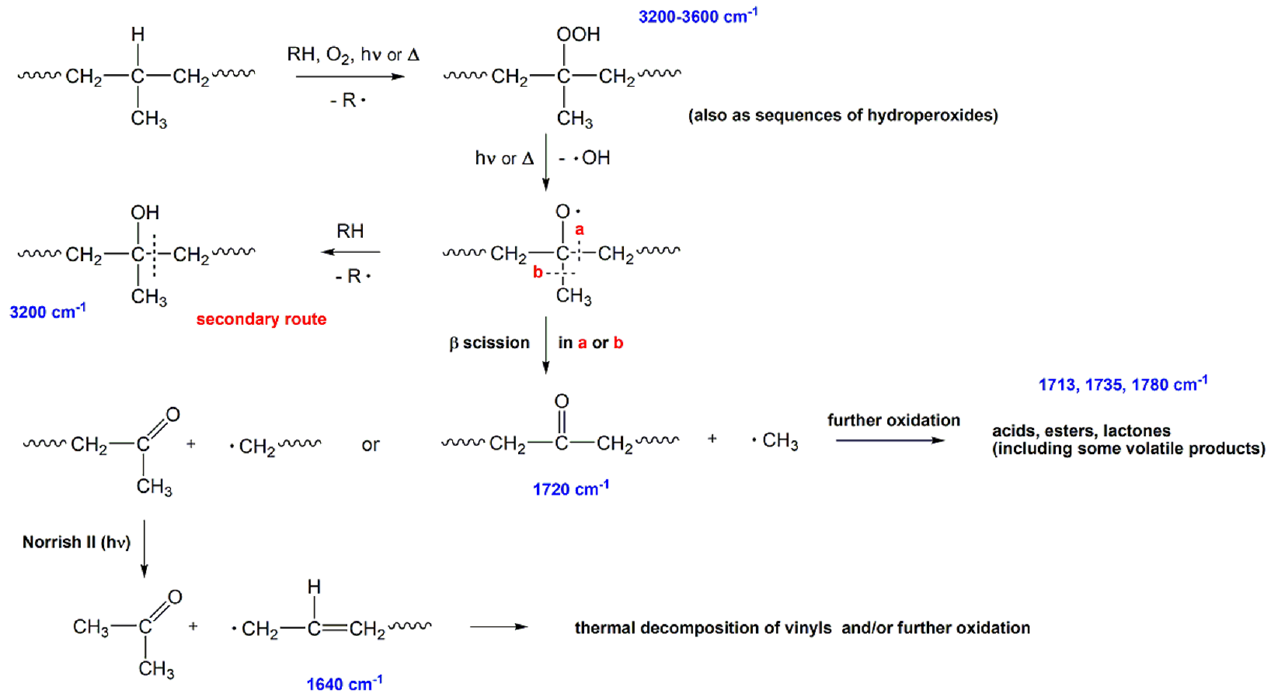
Scheme 1. Main route of oxidation of PP, with the indication of the absorption bands of the main degradation products in FTIR spectra [27,36]. RH: polymer molecule; R: polymer radical; h ν : light; Δ : heat.